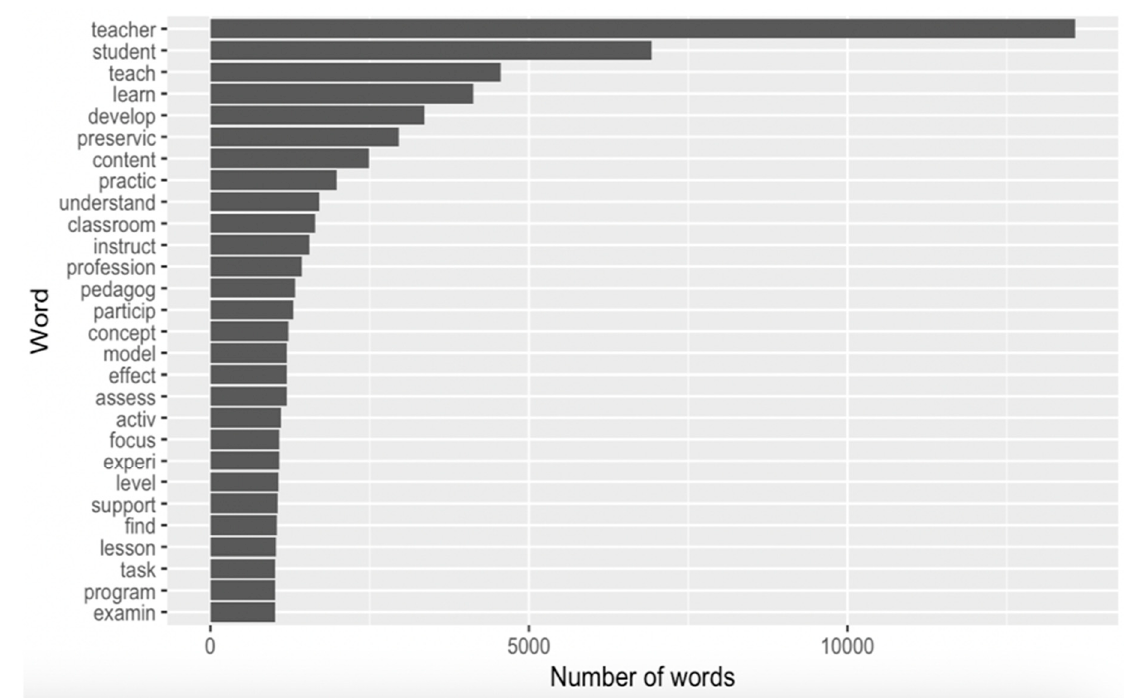
Figure 6. Words with more than 1000 frequency in abstracts.